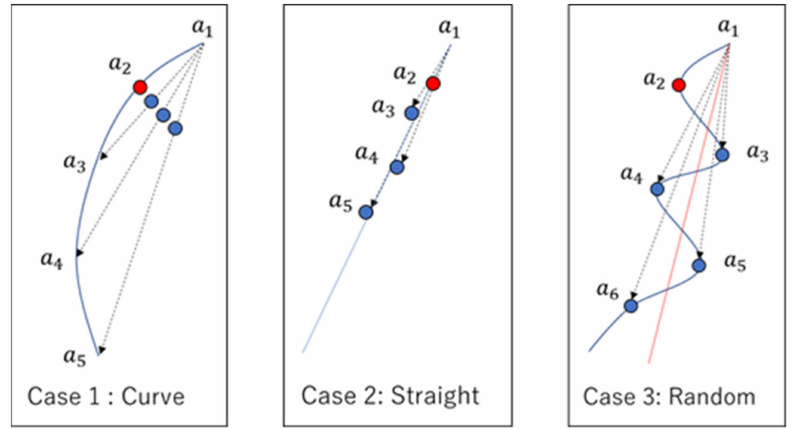
Figure 9. Three patterns of the estimated value in this study using Equation